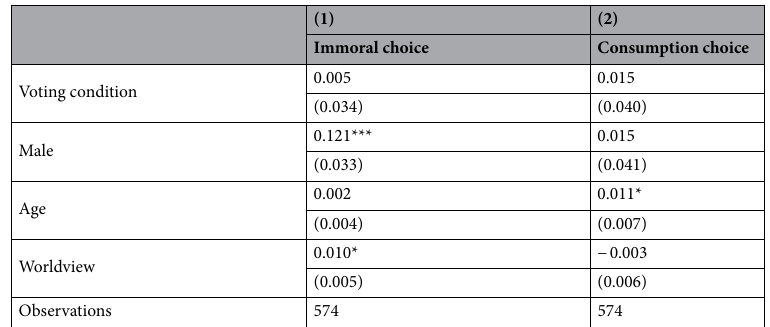
Table 1. Logistic regression for the effect of majority voting on the immoral decision and the consumption decision in Study 1. Coefficients represent marginal effects (at means), standard errors in parentheses. Dependent variable in (1) is Immoral behavior = 1 if subjects chose 63 SEK for themselves, and = 0 if subjects instead chose donation to UNICEF. Dependent variable in (2) is consumption choice = 1 if subjects chose 30 SEK for themselves, and = 0 if subjects chose the thermos mug. Worldview score is a continuous variable (ranging from 6 to 24), where 6 is the most collectivistic score and 24 is the most individualistic